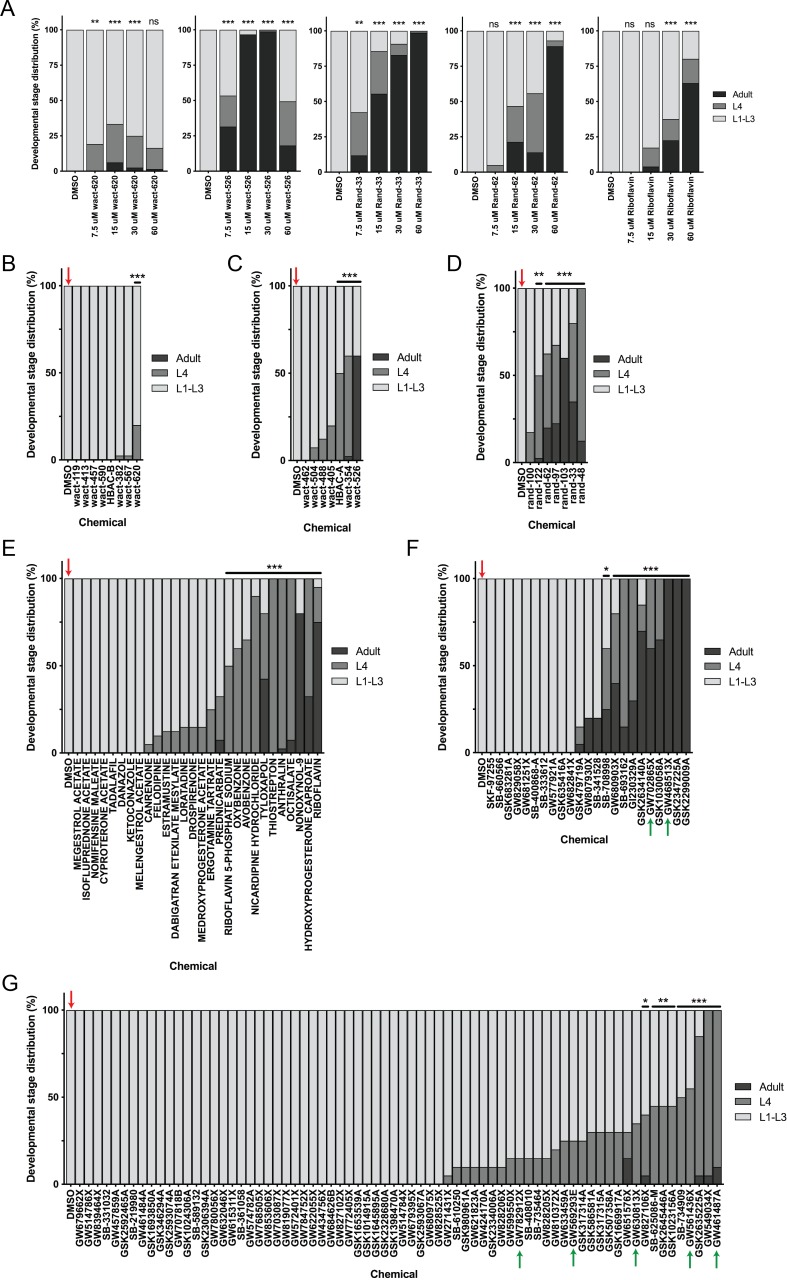
Follow-up testing for compounds identified in the primary screen.(A) Chemical dose-response re-testing of five compounds shows consistent ability to suppress nemadipine-A-induced growth arrest of unc-68 mutants. Note: wact-526 precipitated at 30 and 60 μM and rand-62 precipitated at 60 μM. (B–G) Post-hoc statistical analysis showing the developmental stage distributions of the 145 re-tested molecules from the primary screen, and identifying those that were significantly different from DMSO wells (red arrows). Again, it is important to note that this was performed while assuming that 20 worms were in each well as a means of estimating the proportion of actual L4 and adult counts in each well. In other words, we assumed #L1-L3 larvae = 20 – (#L4 + #adult). Plots shown are from independent screens of (B) 7.5 μM wactives, (C) 60 μM wactives, (D) 60 μM ‘random’ non-wactives, (E) 60 μM US Drug Collection and (F-G) 60 μM GlaxoSmithKline Published Kinase Inhibitor (PKI) set. In the PKI set, p38 inhibitors that suppressed growth arrest are highlighted by green arrows. Statistical analysis by Kruskal-Wallis test with Dunn’s multiple comparisons post-test where *p<0.05, **p<0.01, ***p<0.001.